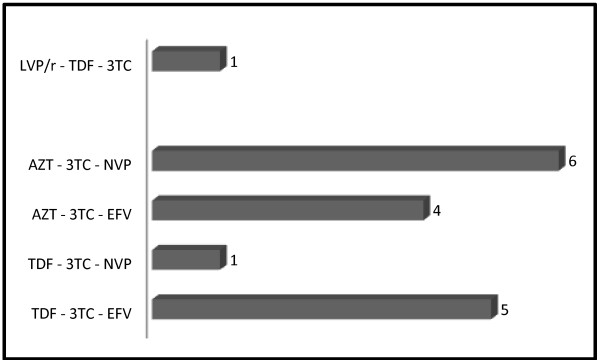
Regimens that have given rise to hyperlactatemia.